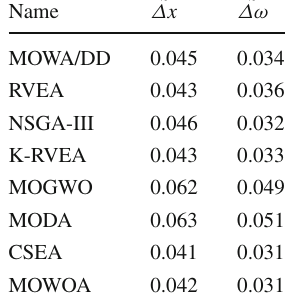
The notation AP means the average propulsive speed The notation HS indicates the head stability The notation PE the propulsive-energy efficiency